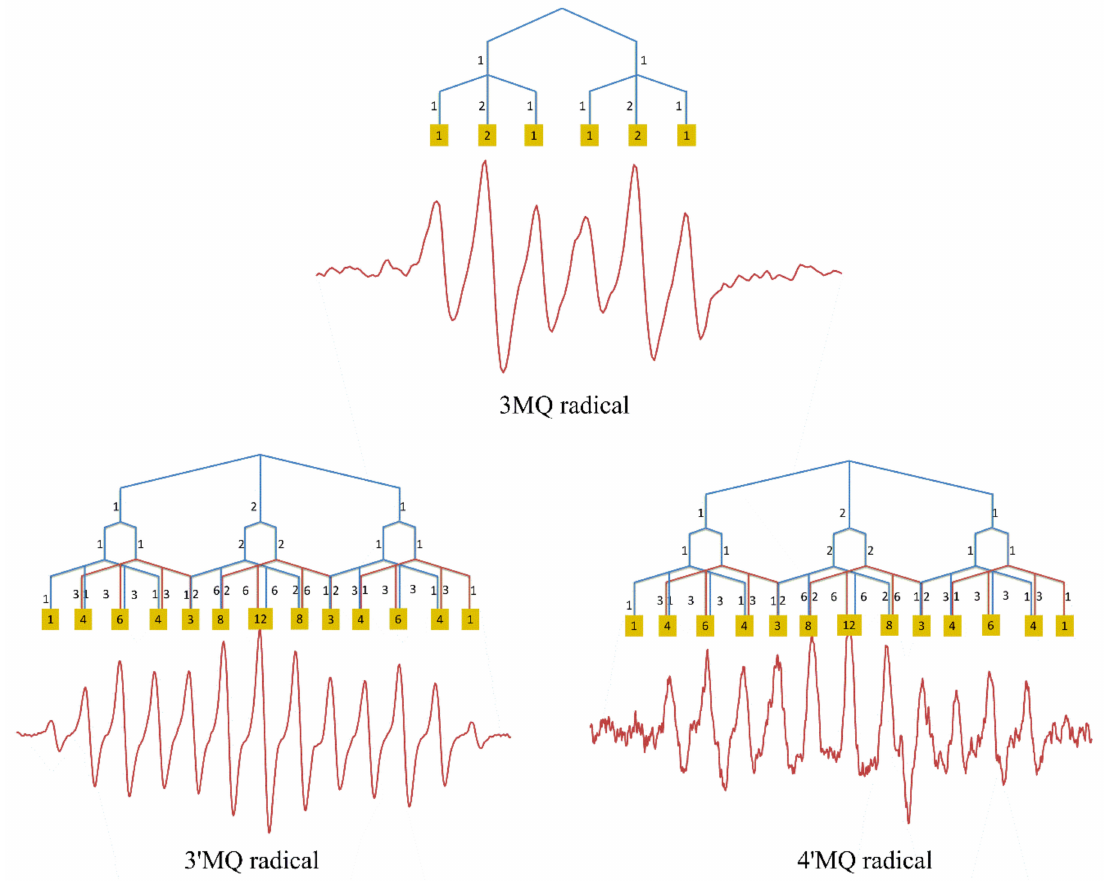
Figure 3. ESR spectra of the radical of the O -methylated derivatives of Q, with the protons causing hyperfine couplings indicated. The relative intensities of peaks are given in yellow